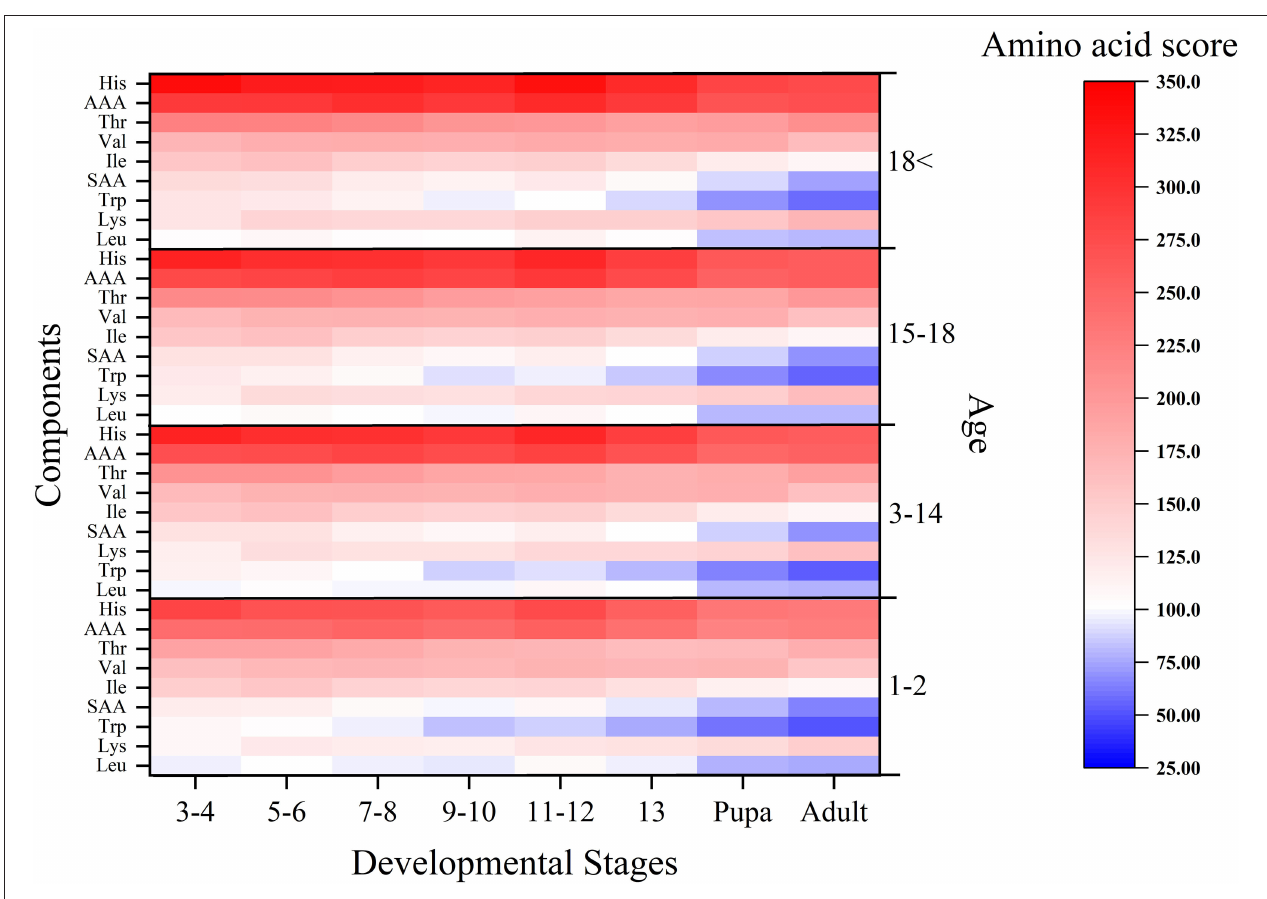
FIGURE 2 | Amino acid scores at the different development stages of Tenebrio molitor for infants, children, adolescents and